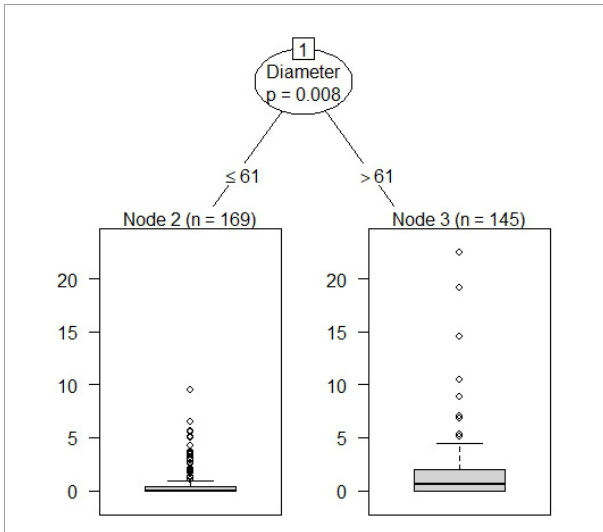
FIGURE2 Determination of the attack intensity of the oak pinhole borer by the threshold of oak stump diameter in the Czechia.